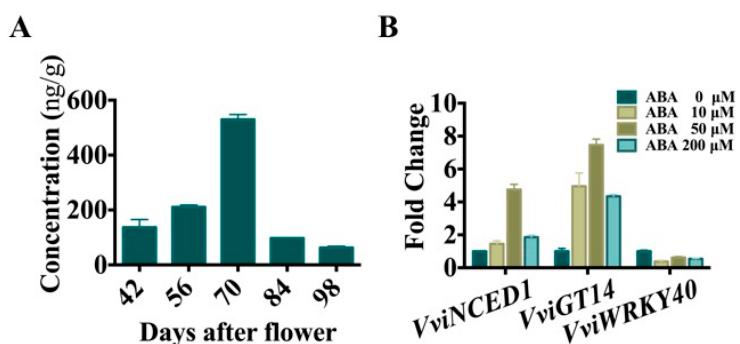
Figure 9. Change of aureobasidin A (AbA) concentration during Vitis vinifera L. “Muscat blanc à Petit grain” grape berry ripening ( A ) and the expression of the VviGT14 , VviNCED1 , and VviWRKY40 genes in Vitis vinifera L. “Chardonnay” suspension cell system treated with different concentrations of ABA. ( B ). At least three biological replicates were carried out, and ANOVA was performed.